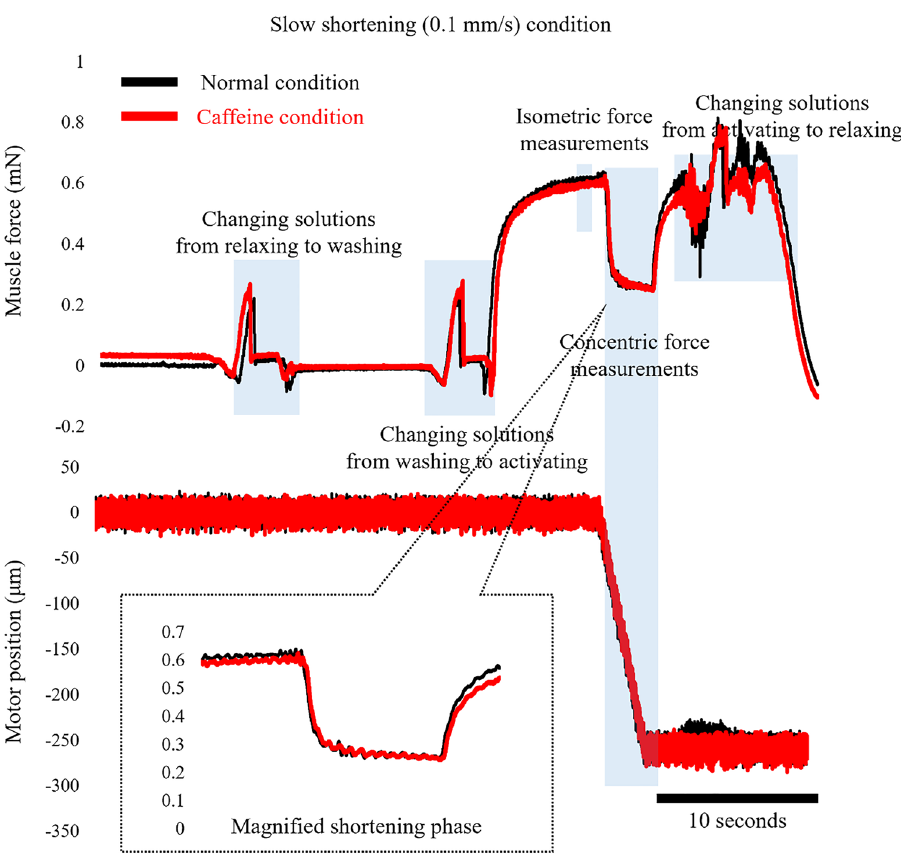
Figure 1. Force and length responses for the normal and caffeine conditions in the slow shortening trials. Black lines indicate the normal condition and red lines indicate the caffeine condition. The inset shows the magnified force responses during the shortening